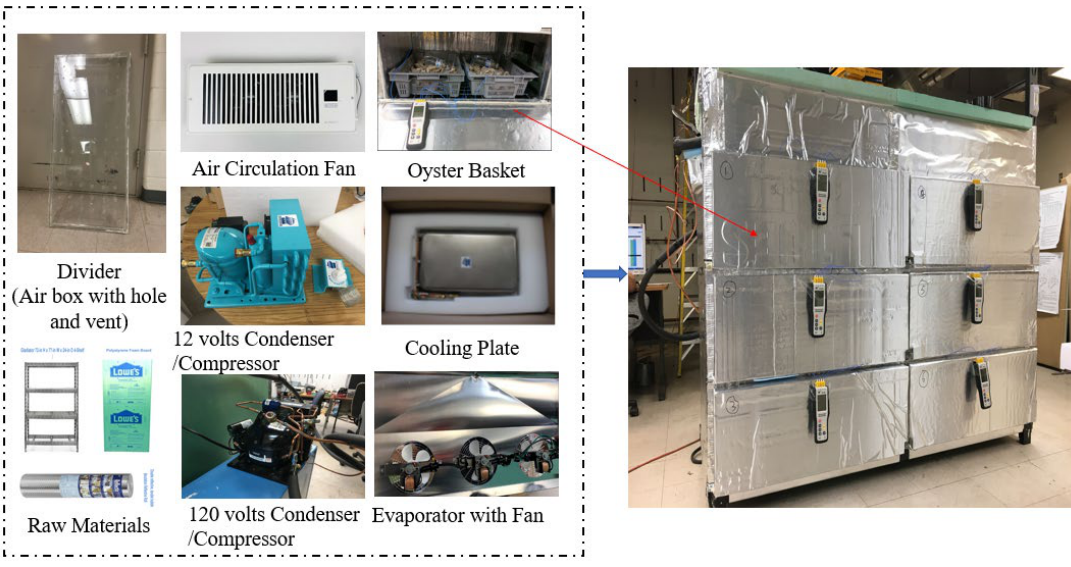
Figure 2. Major components and materials of the lab-scale hybrid oyster refrigeration system.